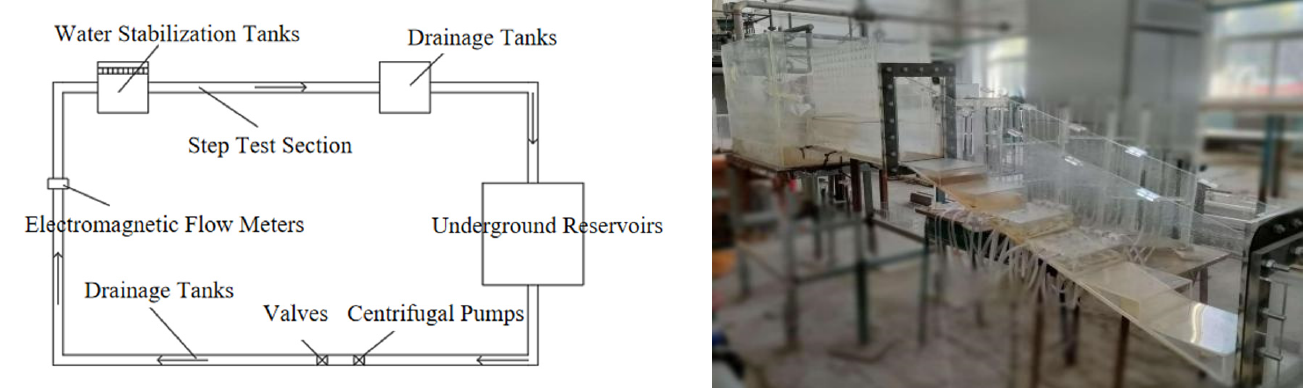
Figure 4. Schematic diagram of the test system.